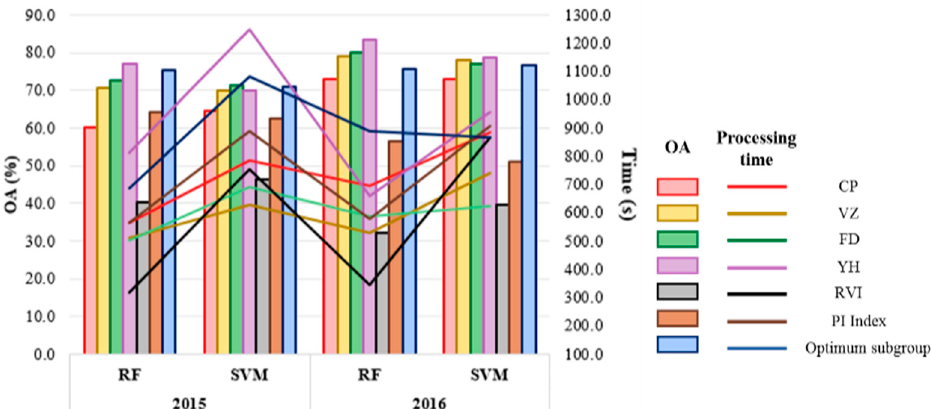
Figure 7. Performance of the RF and SVM classifiers in relation to the OA and processing time for 2015 and 2016. CP: Cloude–Pottier decomposition; VZ: van Zyl decomposition; FD: Freeman–Durden decomposition; YH: Yamaguchi decomposition; RVI: Radar Vegetation Index; and PI: Pope